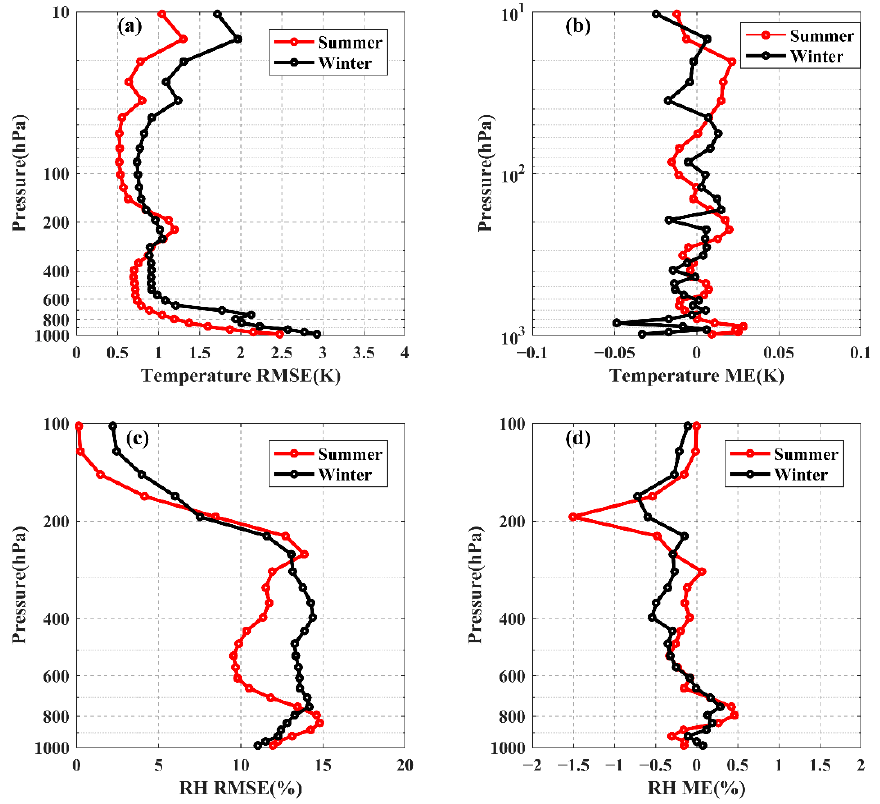
Figure 6. Profile retrieval errors for ( a , b ) temperature, ( c , d ) RH, with respect to ERA5 on